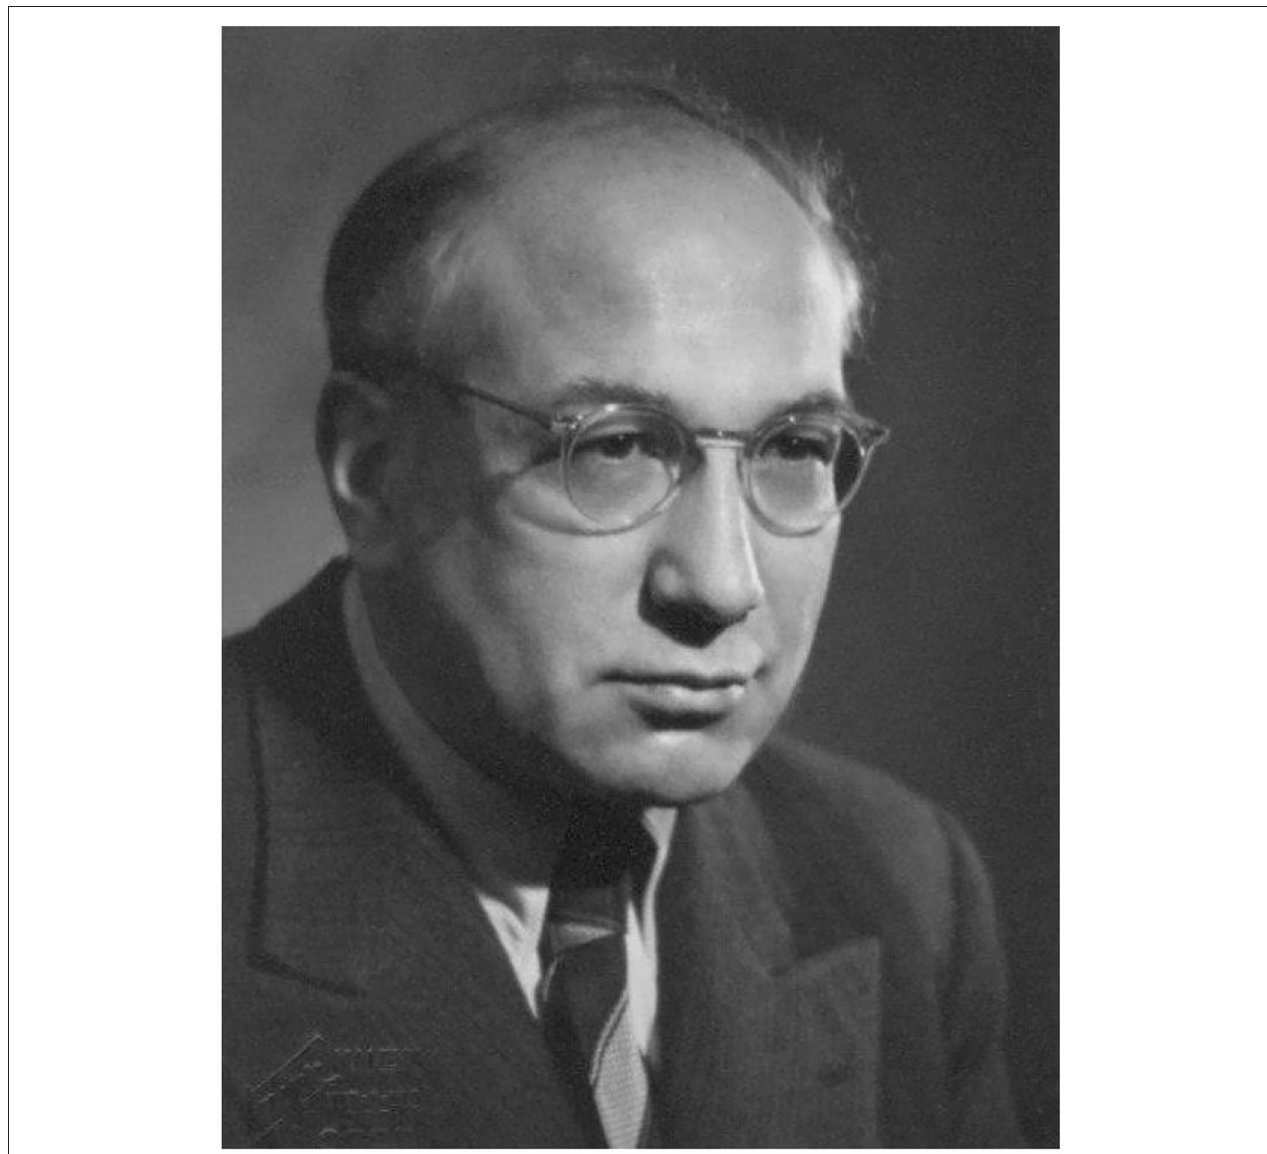
FIGURE 3 | Hans Hoff (1897-1969), Austrian neurologist and psychiatrist. Source: Archives of the University of Vienna,